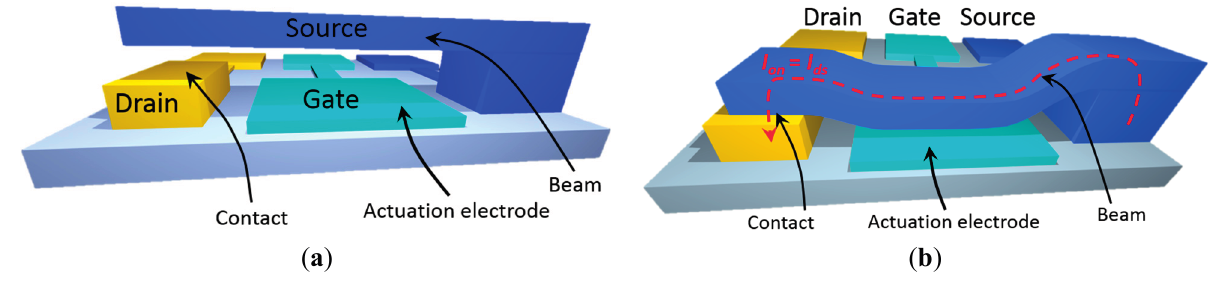
Figure 3. Illustration of an electrostatic 3T relay: ( a ) as fabricated, ( b ) actuated into the ON